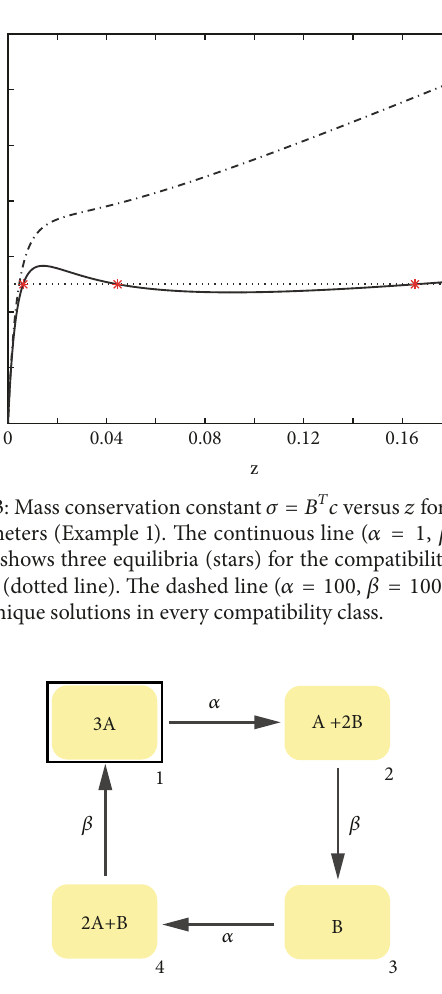
Figure 4: Example 2: weakly reversible network with ℓ = 1 and 𝑁 = 4 .